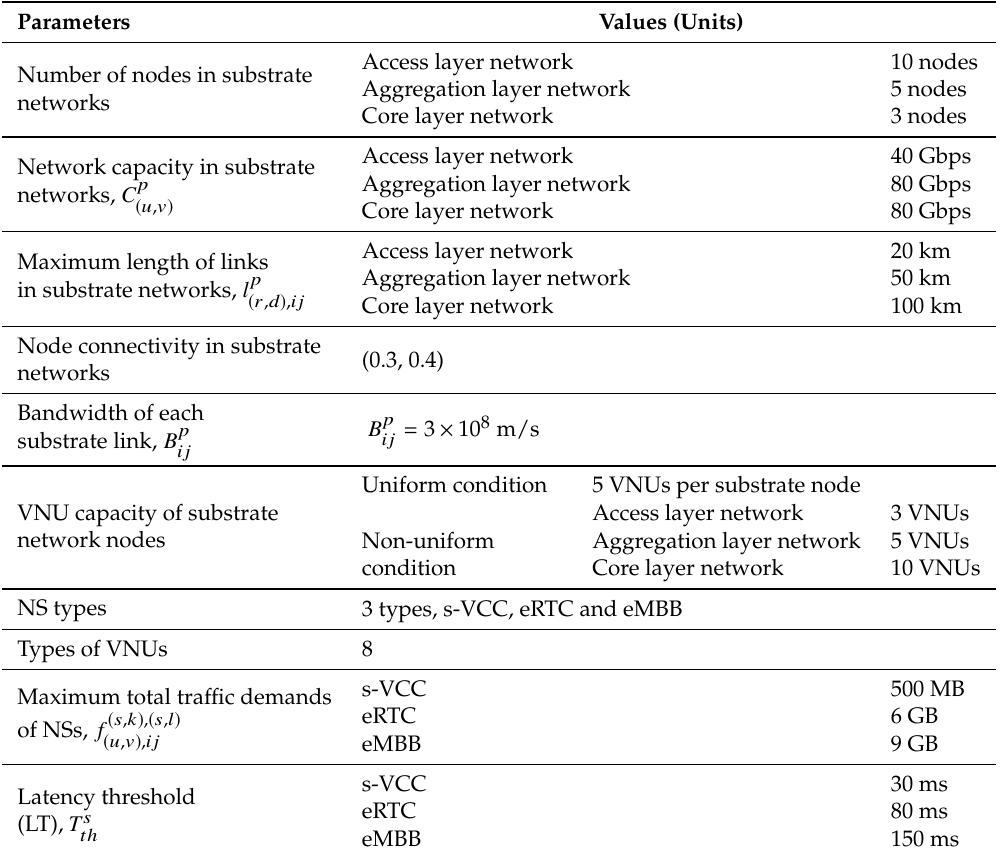
Table 2. Simulation